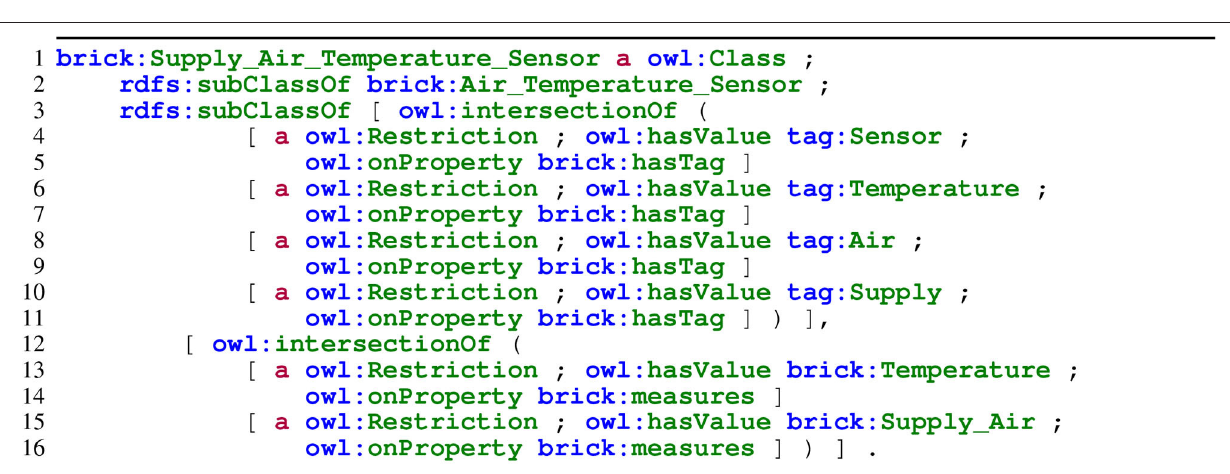
temperature , air and supply tags. Lines 18-25 define